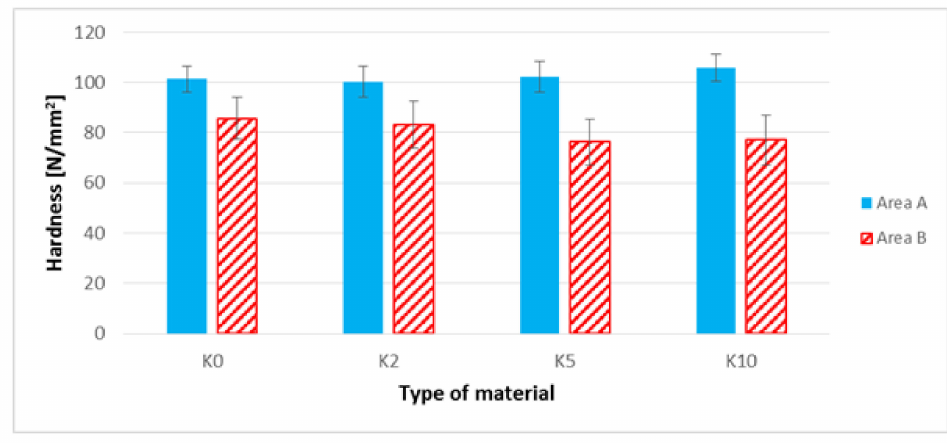
Figure 13. Hardness of composites filled with hemp fibers before and after surface modification in areas A and B of the sample.